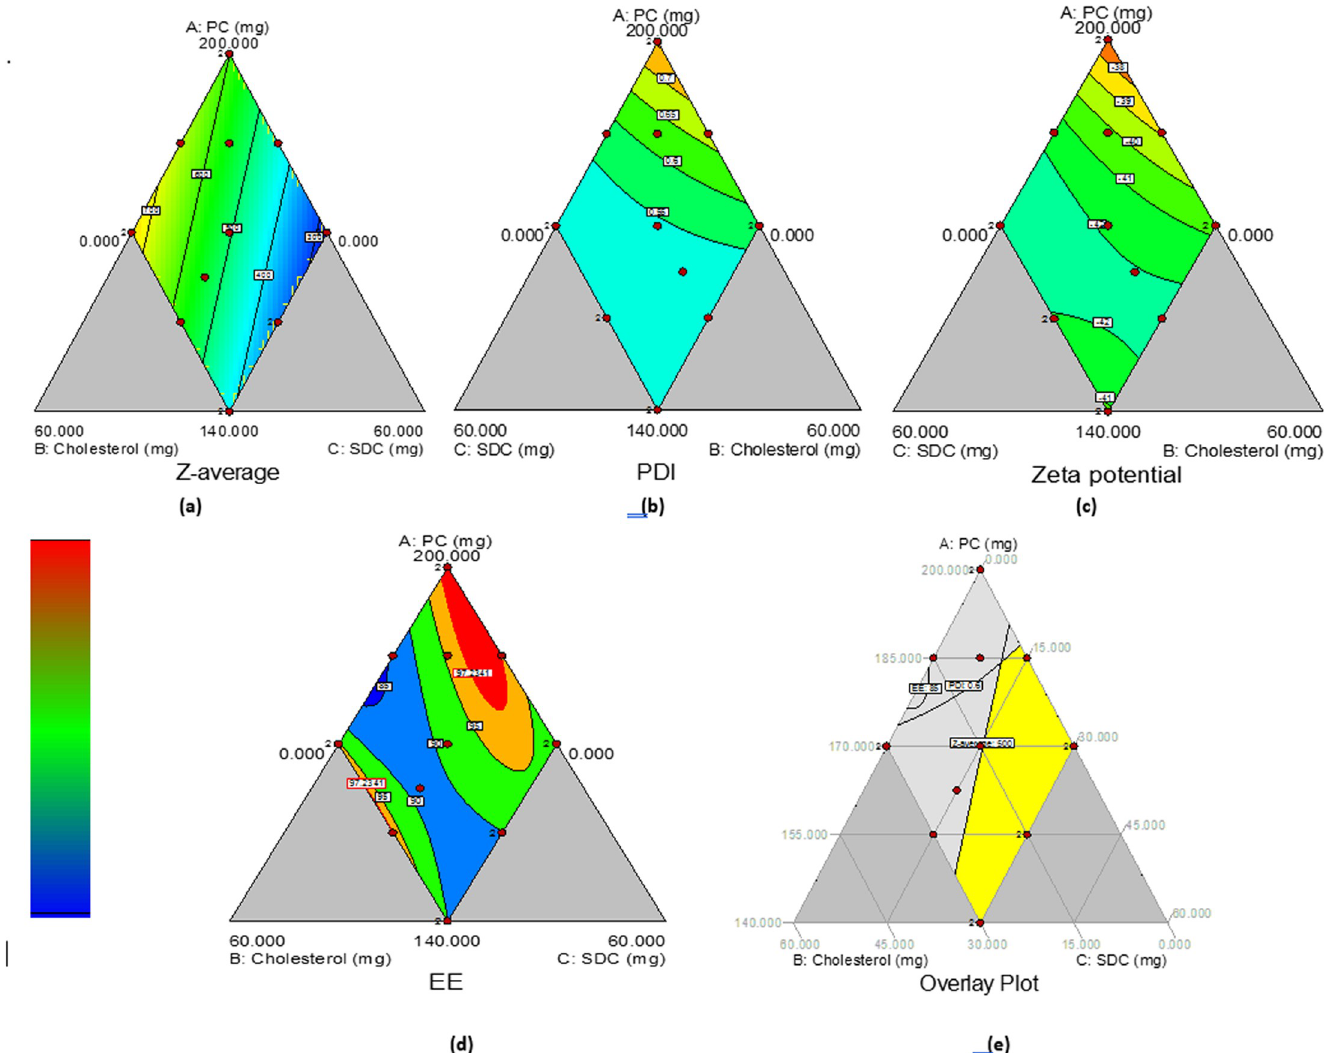
Fig 1. Contour plots of the impact of variables on the vesicle size (Y1) (a), PDI (Y2) (b), ZP (Y3) (c) and EE (Y4) of BBVs preparations and Overlay plot for the impact of different variables on the responses.